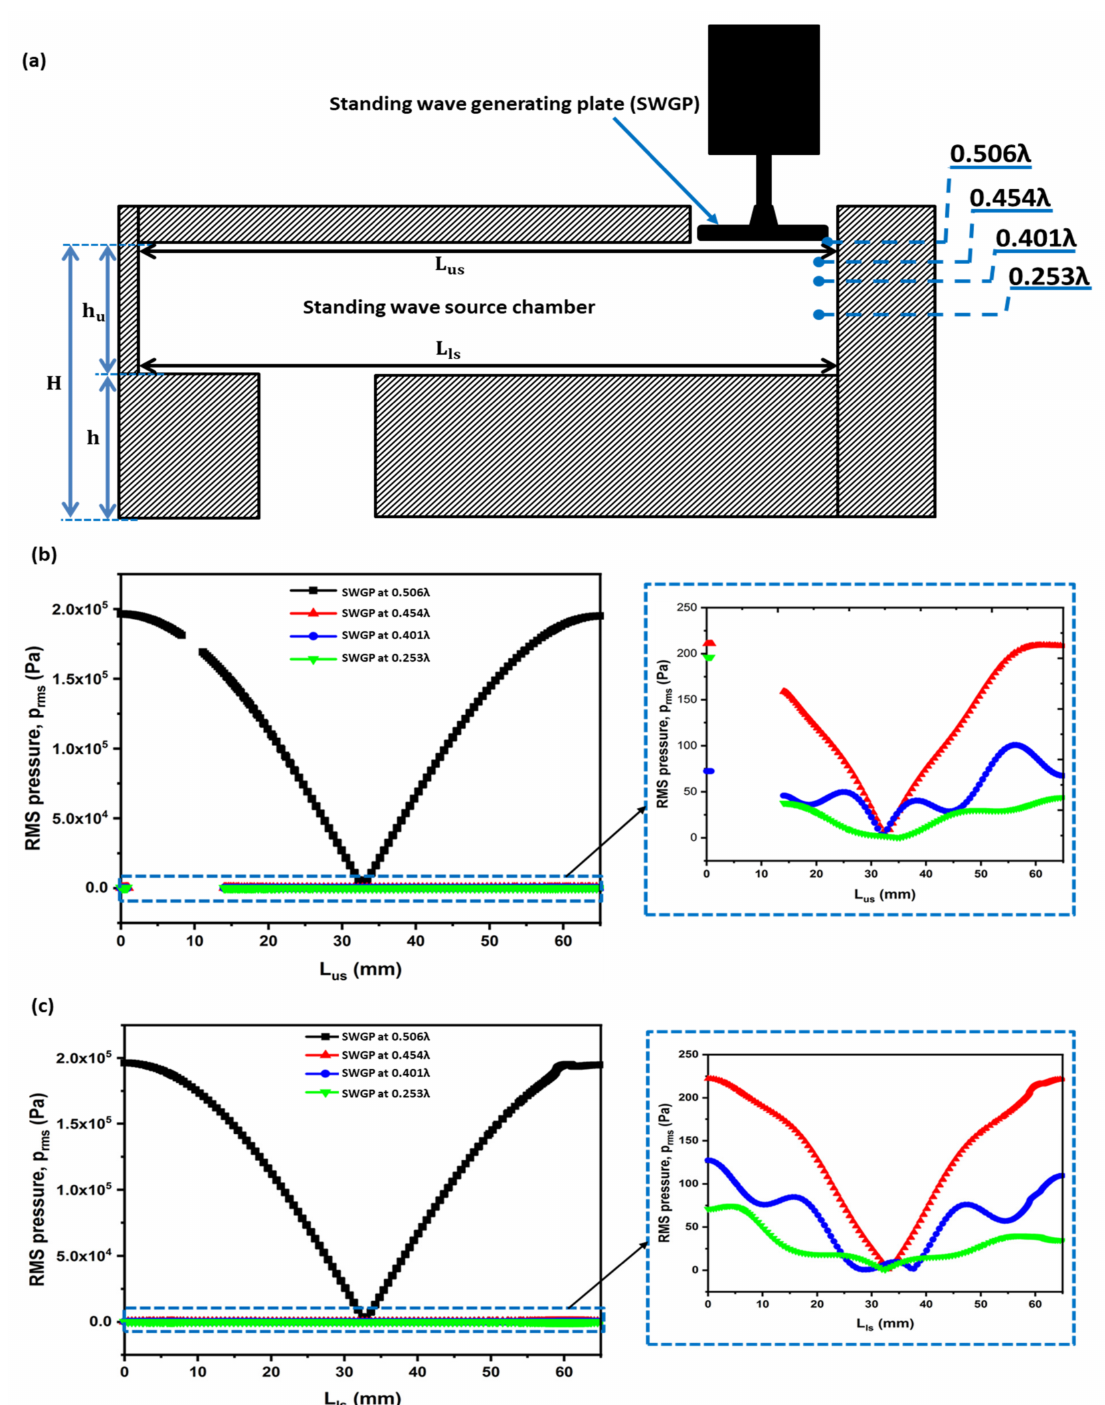
Figure 9. ( a ) Schematic cross-sectional representation of SWAM showing four different positions at which the SWGP is actuated and numerical simulation results of RMS pressure across the ( b ) upper surface length (L us ) and ( c ) lower surface length (L ls ) of the standing wave-source chamber when the SWGP was actuated at 0.506 λ , 0.454 λ , 0.401 λ , and 0.253 λ